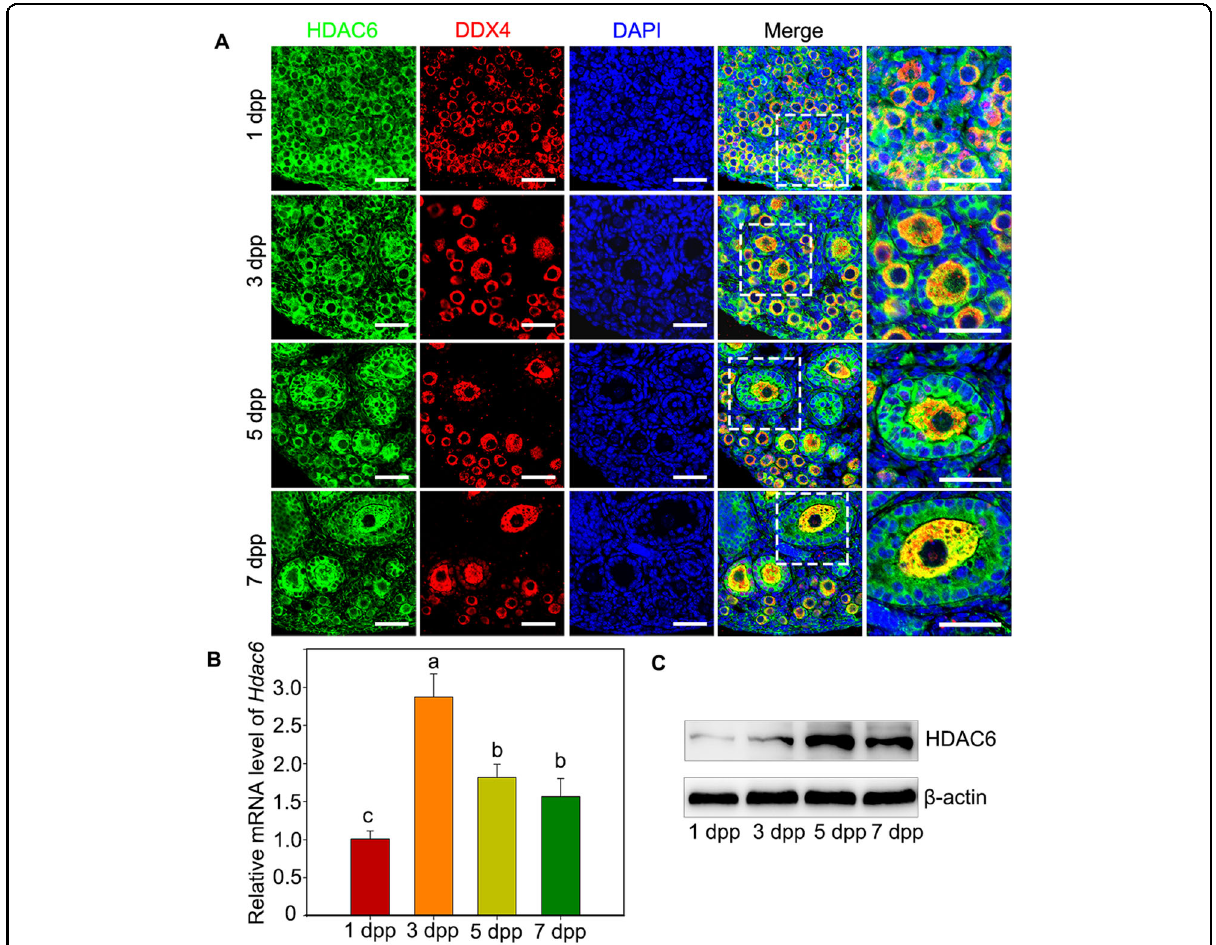
Fig. 1 The expression pattern of HDAC6 in the neonatal mouse ovaries. A Cellular localization of HDAC6 in newborn ovaries. Newborn mice ovaries were stained for HDAC6 (green) and the oocyte speci fi c marker DDX4 (red) at the indicated time points. The nuclei were counter-stained by DAPI (blue). HDAC6 was mainly localized to the cytoplasm of both oocytes and granulosa cells in either primordial follicles or growing follicles. B qRT- PCR assay showed that the expression level of Hdac6 mRNA was increased from 1 dpp to 5 dpp and decreased on 7 dpp. C Western blotting assay showed that the level of HDAC6 protein was increased from 1 dpp to 5 dpp and decreased on 7 dpp as well. The experiments were repeated at least three times. And representative images are shown. The data are presented as the means ± SEM. Scale bars: 50 μ